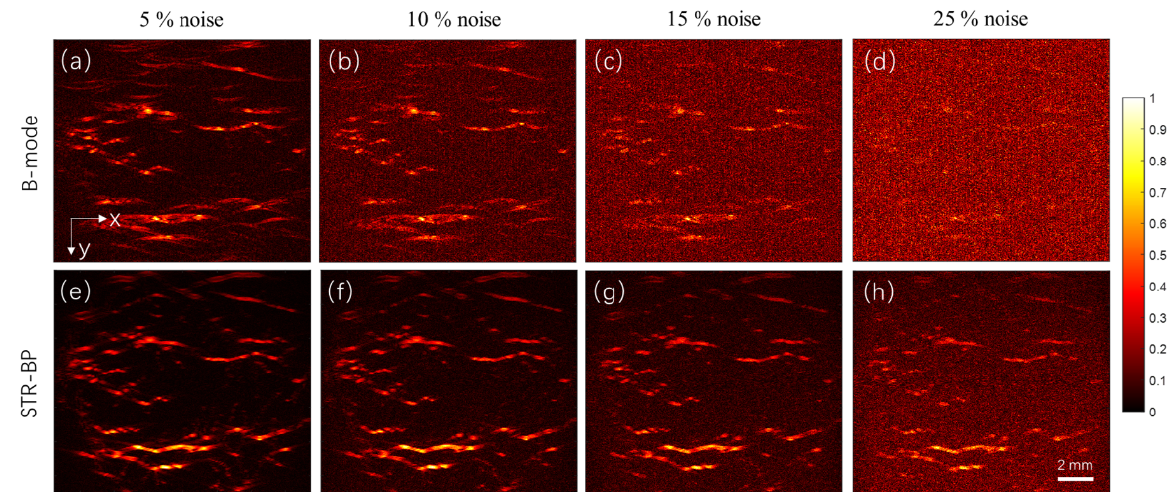
Figure 8. Reconstructed results of a digital blood vessel network with different central frequencies and NAs of the transducer by the STR-BP method. ( a – d ) The reconstruction results when the central frequencies are 5, 10, 20, and 40 MHz, respectively, and ( e – h ) the reconstruction results when the aperture size of the transducer is 2, 4, 6 and 10 mm, respectively.